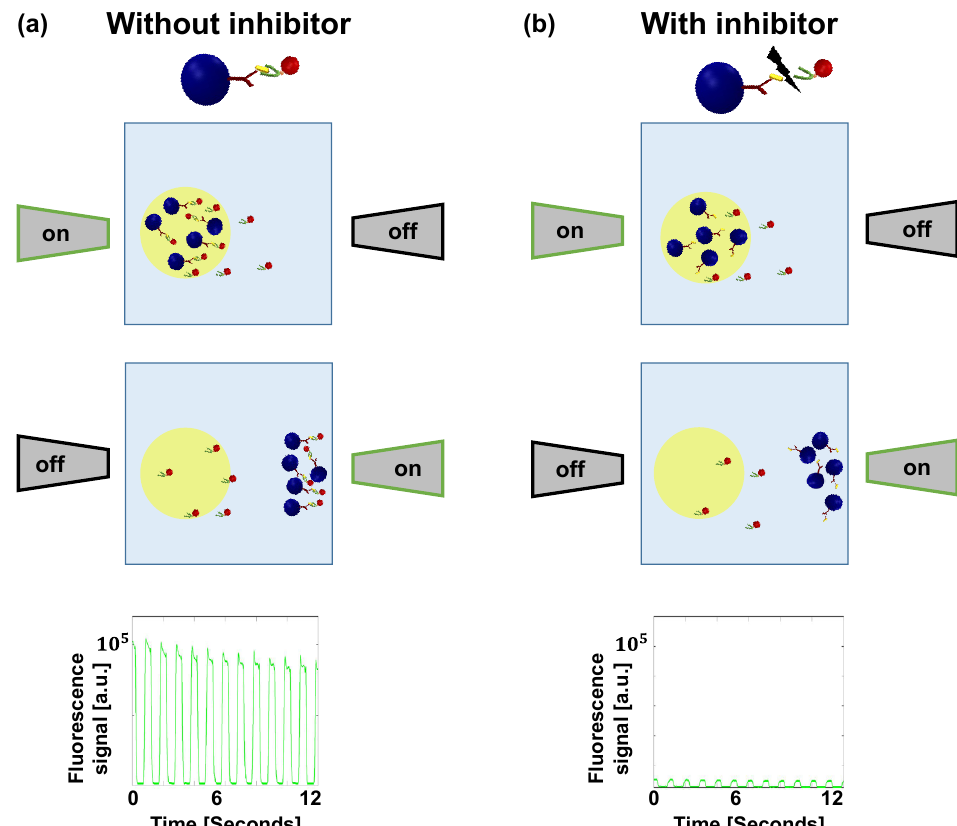
Figure 2. Illustration of magnetically modulated biosensors (MMB) with and without an inhibitor. ( a ) Two electromagnets, positioned on opposite sides of a sample cell, aggregate the magnetic beads and transport them in and out of an orthogonal laser beam. Without an inhibitor, the S1 protein interacts with the fluorescently labeled ACE2 receptor protein, and thus, when the magnetic beads pass through the laser beam, the fluorescence emission is high. Consequently, the average peak-to-peak signal is high. ( b ) When an inhibitor interferes with the interaction, the magnetic beads are not attached to the fluorescently labeled ACE2, and therefore, when the beads pass through the laser beam, the fluorescence emission is low. Consequently, the average peak-to-peak signal is small.